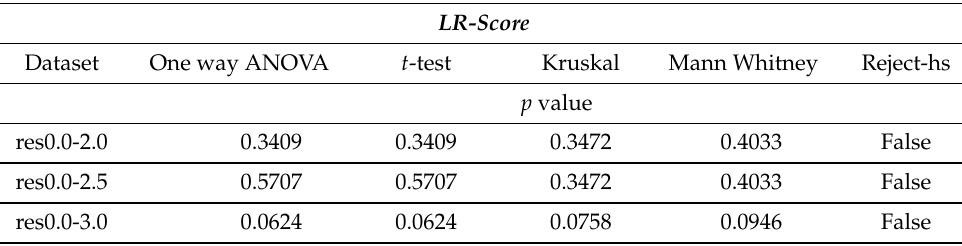
Table 4. Statistical significance between CVAE-SPP and β CVAE-SPP models for each 3 datasets res0.0- 2.0 (first row), res0.0-2.5 (second row) and res0.0-3.0 (third row) are determined through different statistical significance test at α = 0.05. Column 1 lists the individual dataset for CVAE-SPP and β CVAE-SPP models comparison. Column 2 shows the “ p -value” using the One-way ANOVA test, Column 3 using the Student’s t -test, Column 4 using the Kruskal–Wallis test and Column 5 using the Mann-Whitney U test. We recall that LR-Score measures the number of long-range contacts in a distance matrix (normalizing by the number of CA atoms). And for both VAE models, we have considered all 5 different configurations on the training